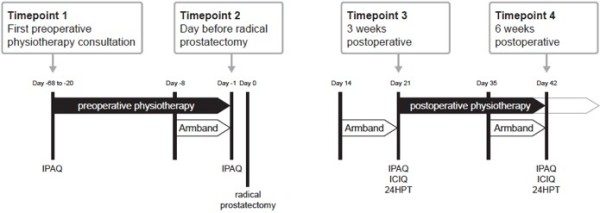
Study timeline outlining the timing of physiotherapy and assessment procedures in relation to radical prostatectomy (Day 0).IPAQ, International Physical Activity Questionnaire; ICIQ, International Consultation on Incontinence Questionnaire – Urinary Incontinence Short Form; 24HPT, 24-hour pad test.